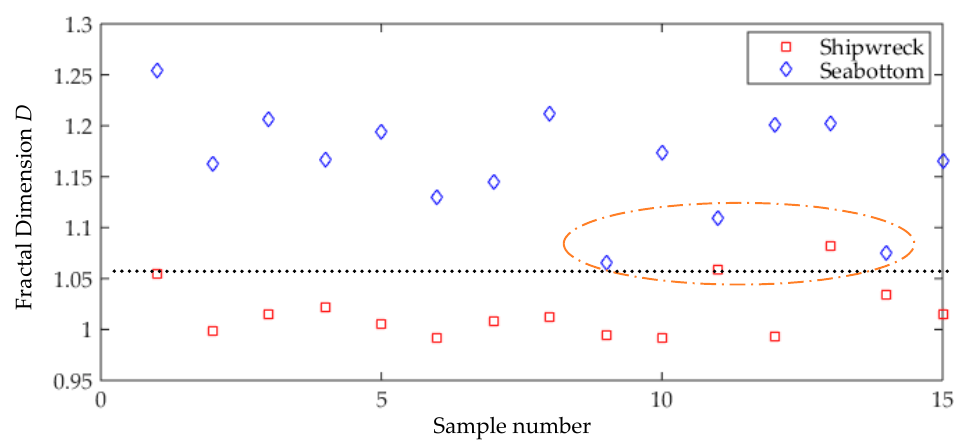
Figure 1. The value of fractal dimension ( D ) calculated by Side Scan Sonar (SSS) images of shipwreck and sea bottom. The black dotted line represents the feature distinguishing value. The elliptical labeling area are the samples difficult to be recognized.